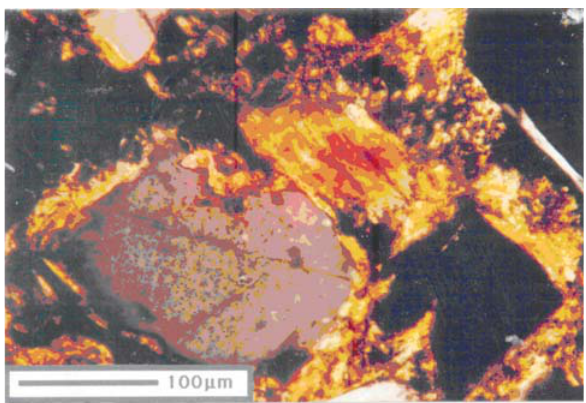
Figura 7. Mesma micrografia do horizonte Bt do perfil 2 com nicóis cruzados. Observam-se argilãs provenientes da intemperização in situ das biotitas circundando um grão de quartzo e a presença de pseudomorfo de